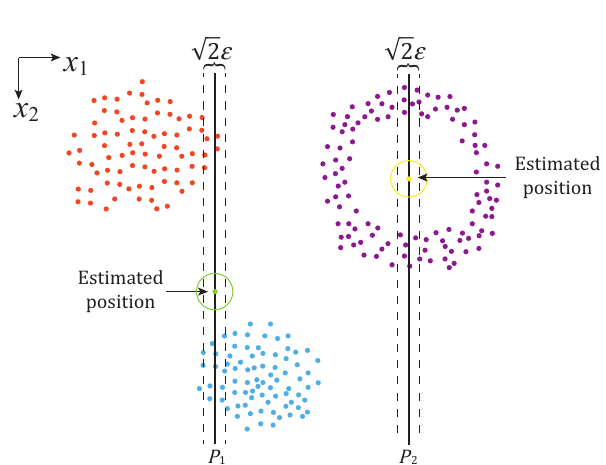
P 2 Fig. 1 An example for incomplete data clustering. dimensions: x 1 and x 2 . " denotes the radius of the neighborhood in the density-based clustering